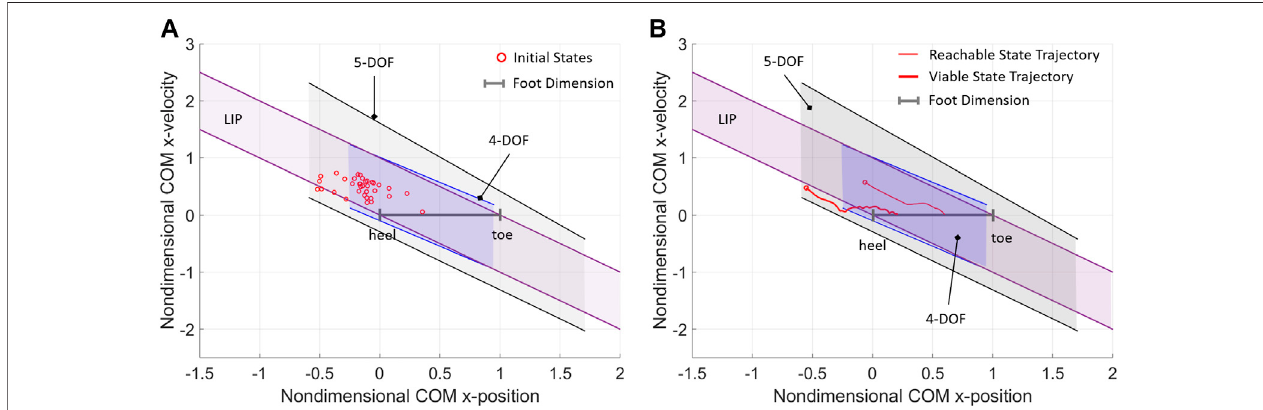
FIGURE6|(A) Acollectionofinitialstatesofasubjectduringexternally-imposedperturbationexperiments(Pattonetal.,1999),comparedwiththenondimensional models of balanced region for standing posture. (B) Two experimental balance recovery trajectories extracted from (Patton et al., 1999), where the subject standing on two feet recovers balance and reaches static equilibrium after receiving an external impulse.